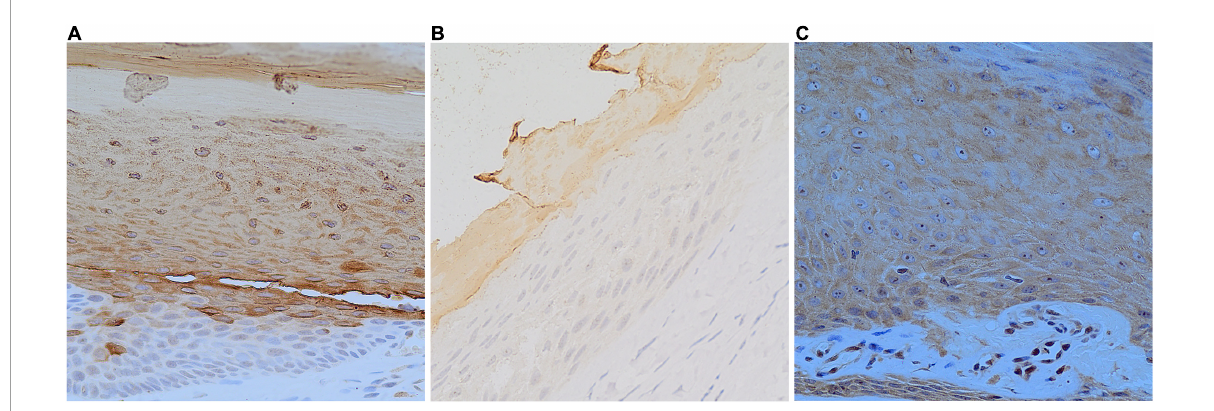
FIGURE3 Longitudinal sections; expression of HK31 in the normal nail unit and onychopapilloma. (A) Normal nail matrix (DAB staining, SP, × 400). (B) Normal nail bed (DAB staining, SP, × 400). (C) Nail bed of onychopapilloma (DAB staining, SP, × 400).